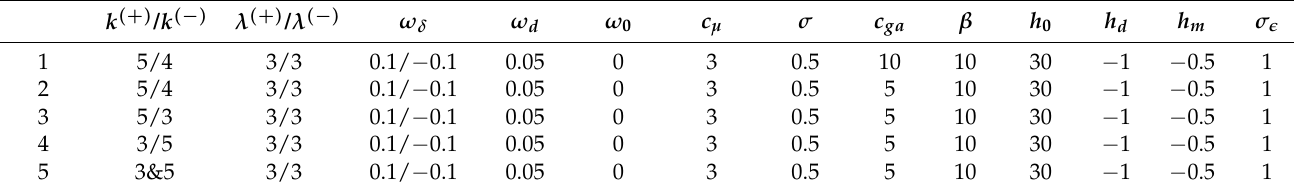
Table 1. Parameter settings for synthetic